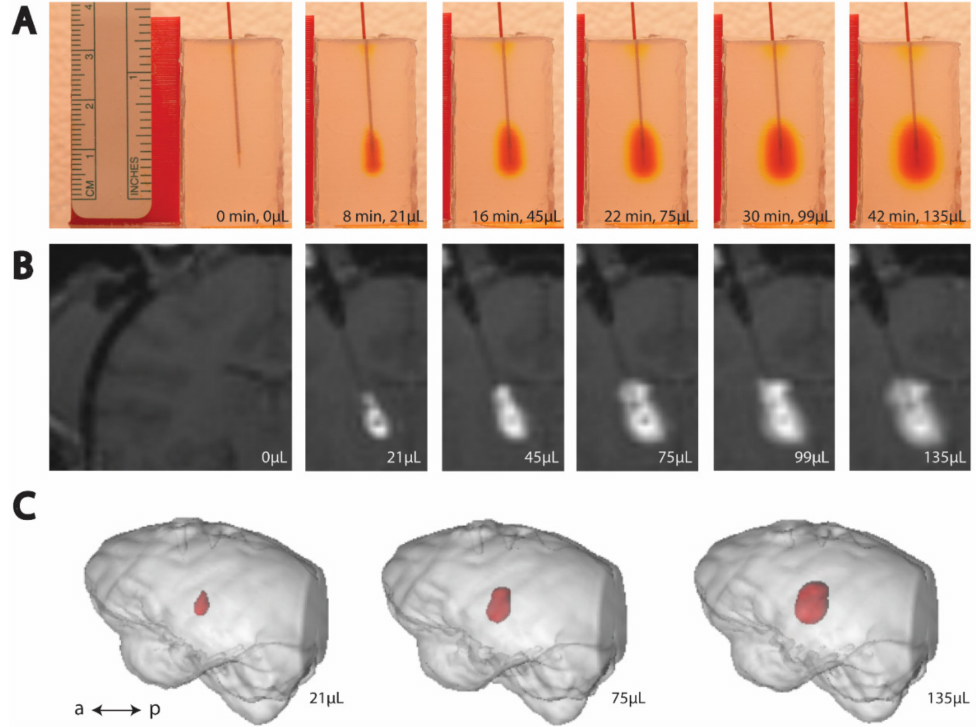
Figure 2. Time-lapse (left to right) of thalamic CED. ( A ) Example trial of CED in agar phantom. ( B ) Example MRI visualization of CED in an NHP. ( C ) Post hoc reconstruction of NHP brain (gray) and infusion volume